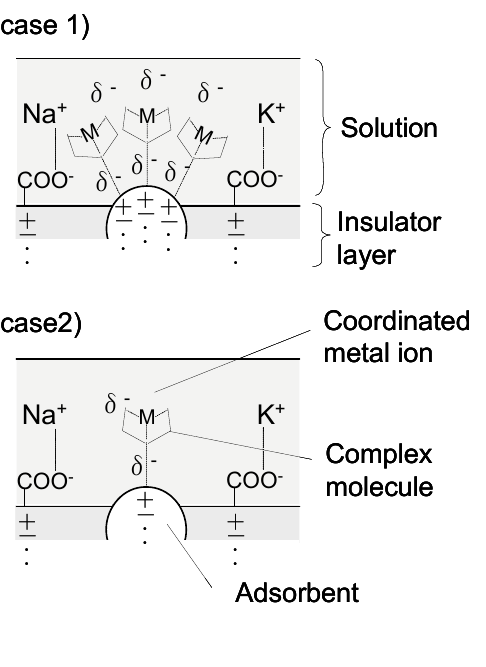
Figure 8. Schematic of the difference in adsorption detection